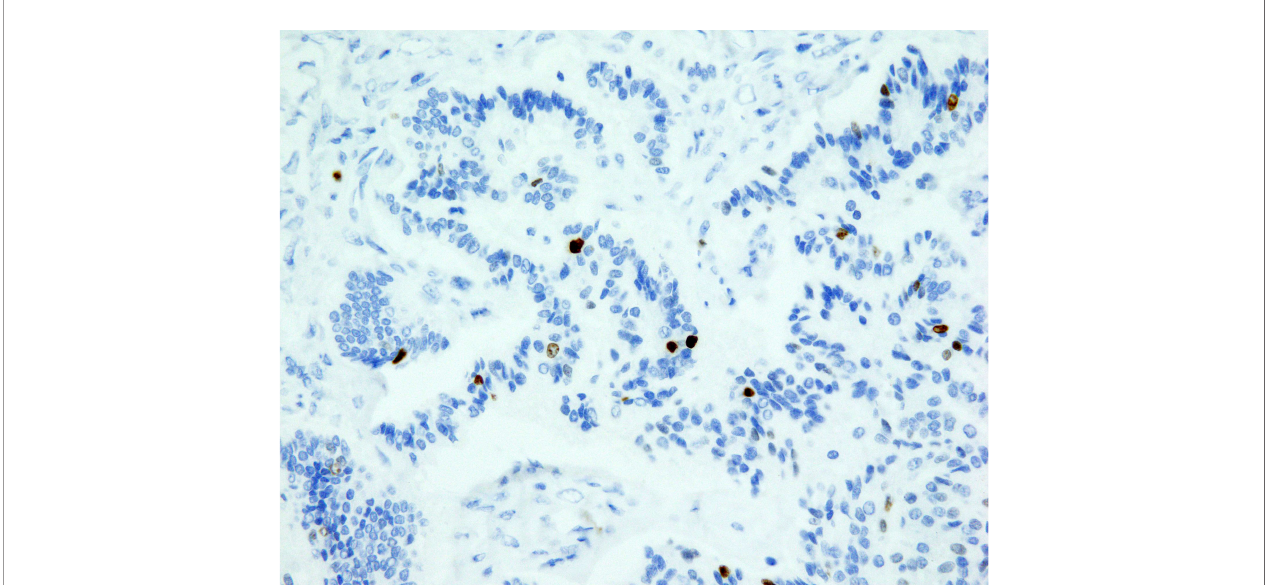
FIGURE 1 | NET focus in teratoma. Ki67 expression in NET foci of teratoma, zoom 40x. Immunohistochemical staining Ki67: proliferative activity around 1%.